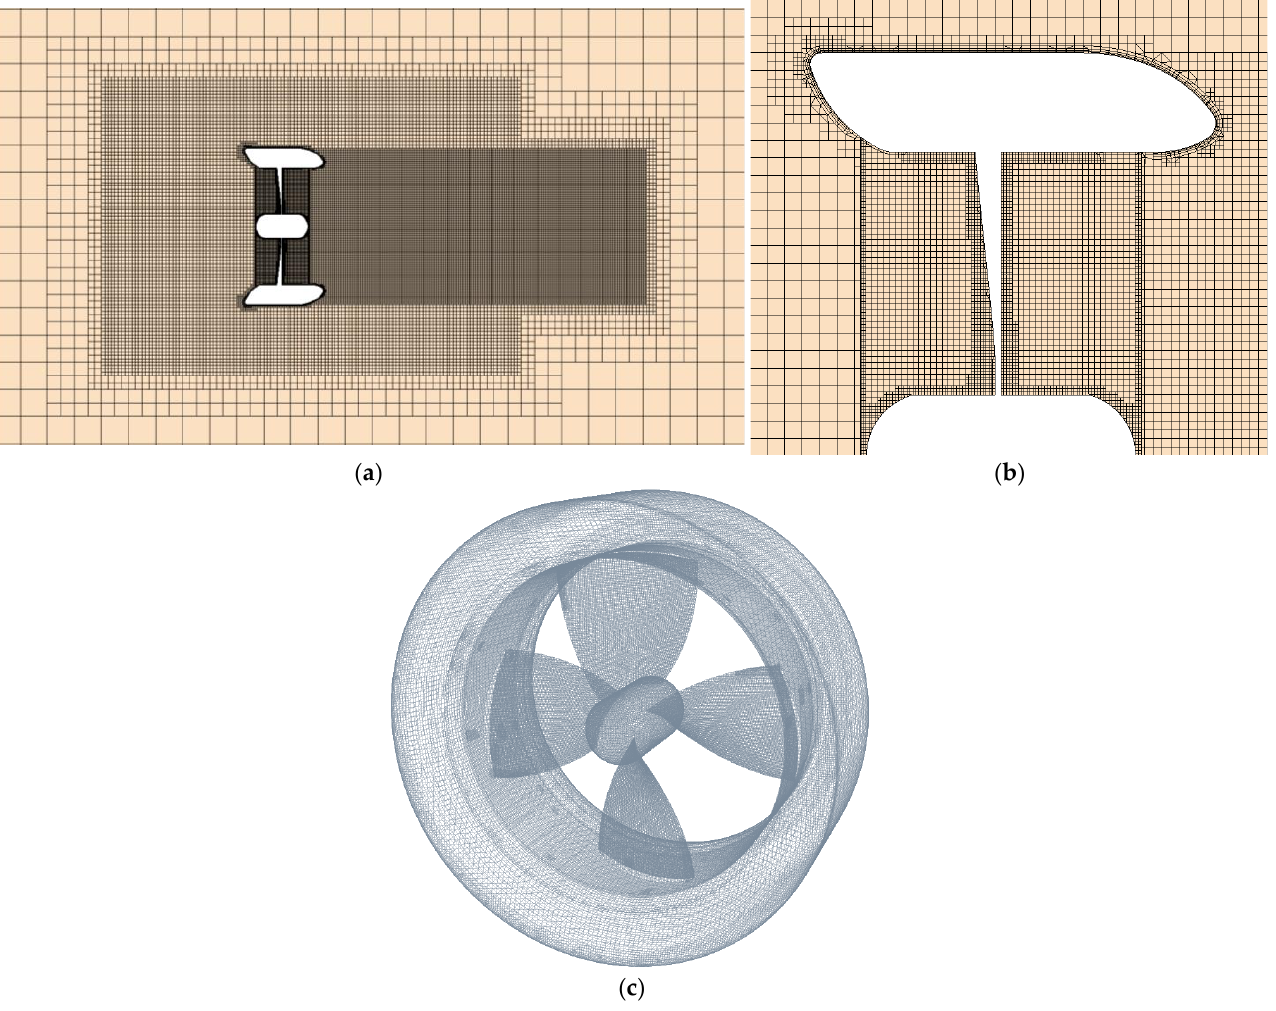
Table 3. Grid sensitivity analysis.